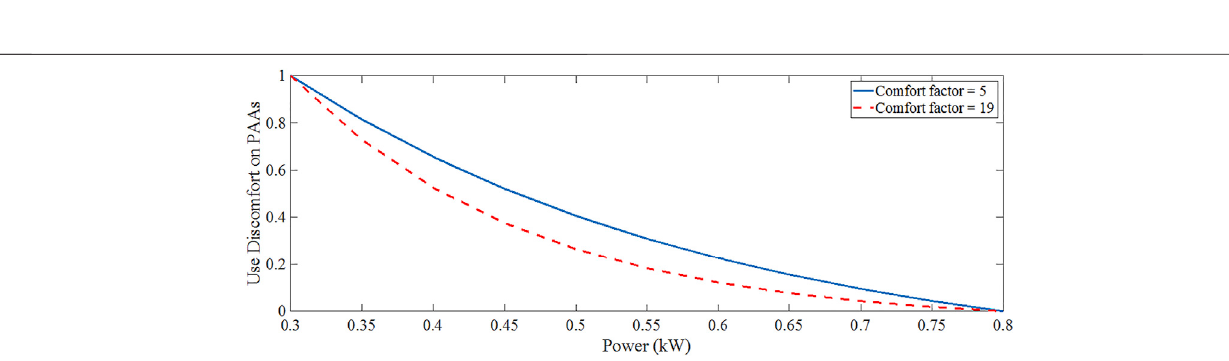
(cid:2) 0 . 8 and P low (cid:2) 0 . 3). i , t run i , m